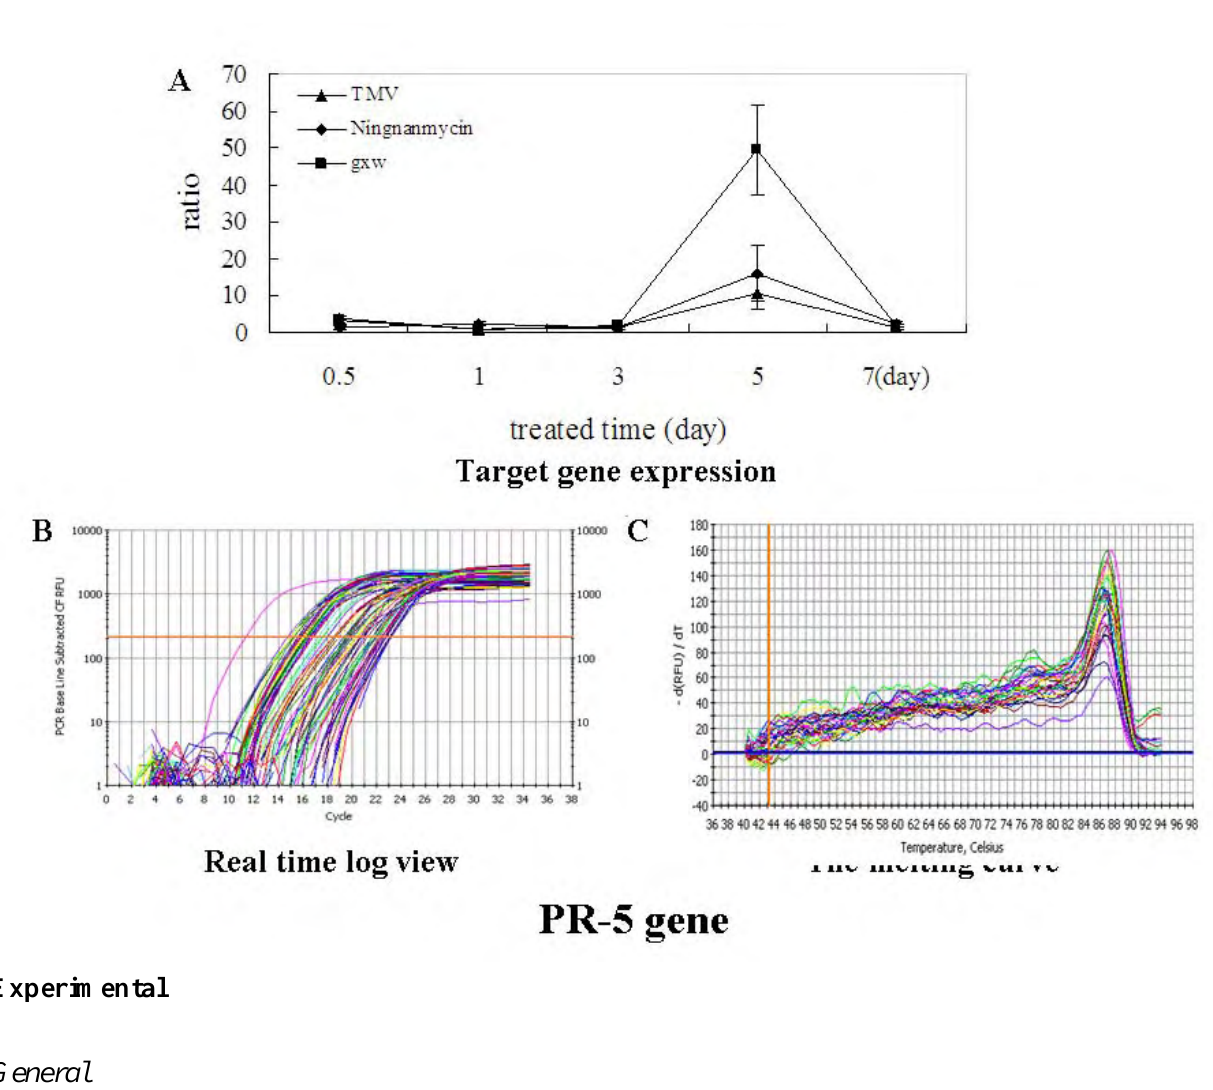
Figure 5. The real time PCR effects of PR-5